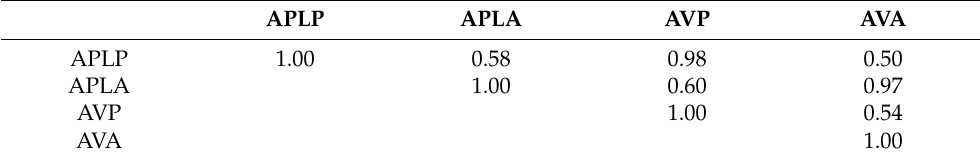
Table 3. Correlation results for the medial-lateral direction (33 subjects).